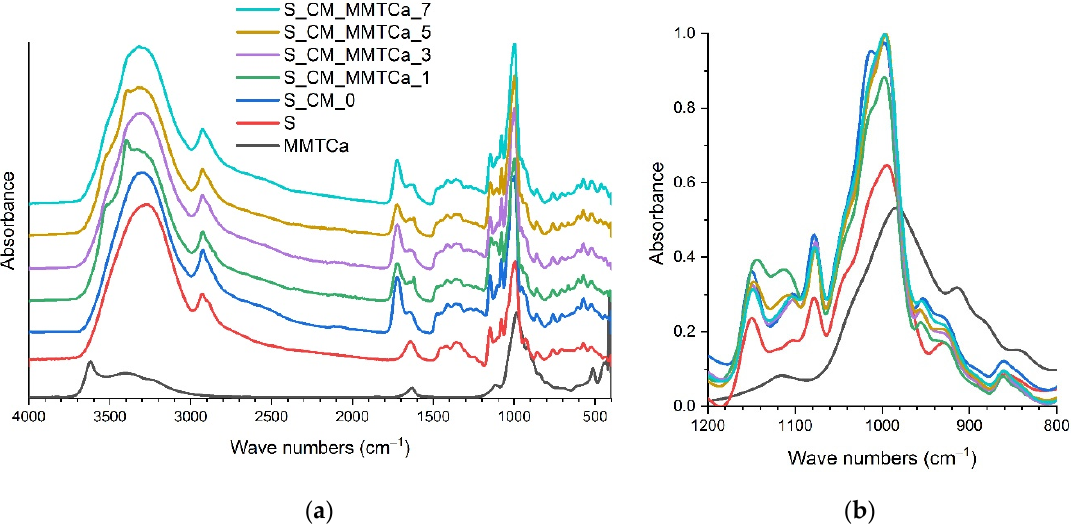
Figure 3. FTIR–ATR spectra of calcium montmorillonite, starch and films with various nanofiller contents: ( a ) full spectrum, ( b ) range 1200–800 cm − 1 .